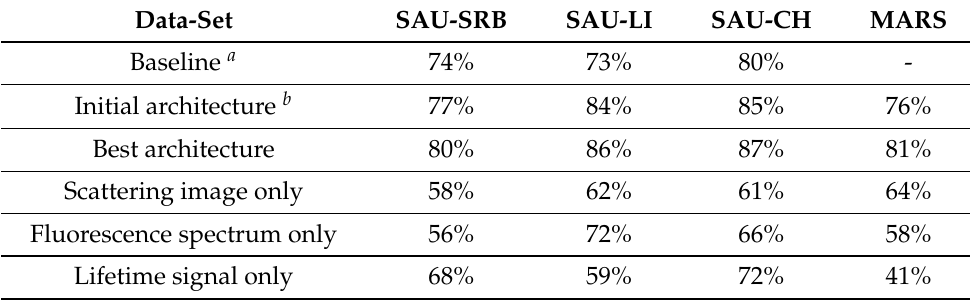
Table 6. Model performance after hyperparameter tuning